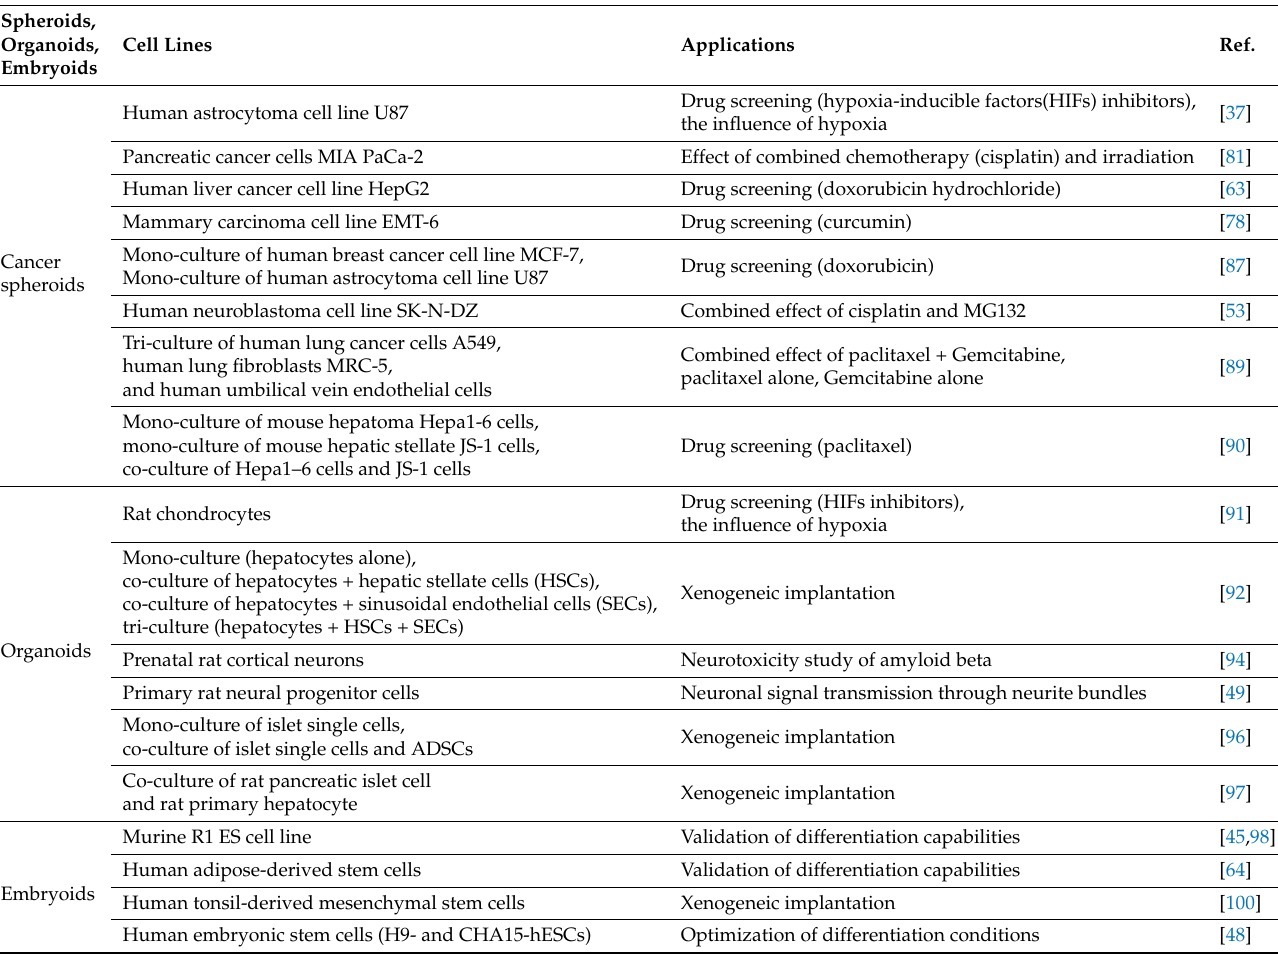
Table 2. Spheroids, organoids, and embryoids by various cell lines and their applications in tissue